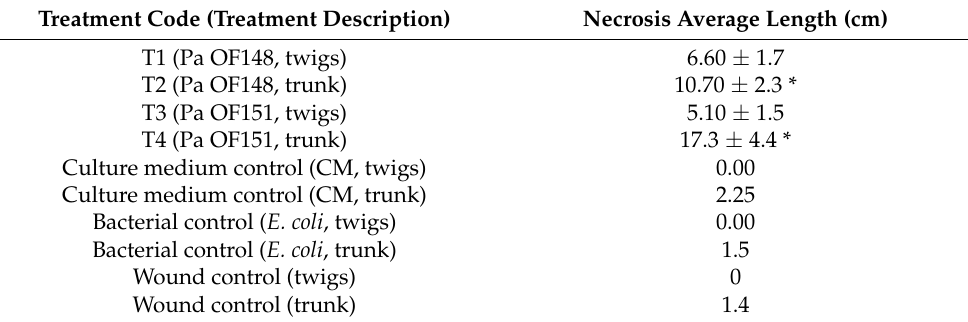
Table 2. Necrosis progression in the different treatments thirty-one weeks post-inoculation.